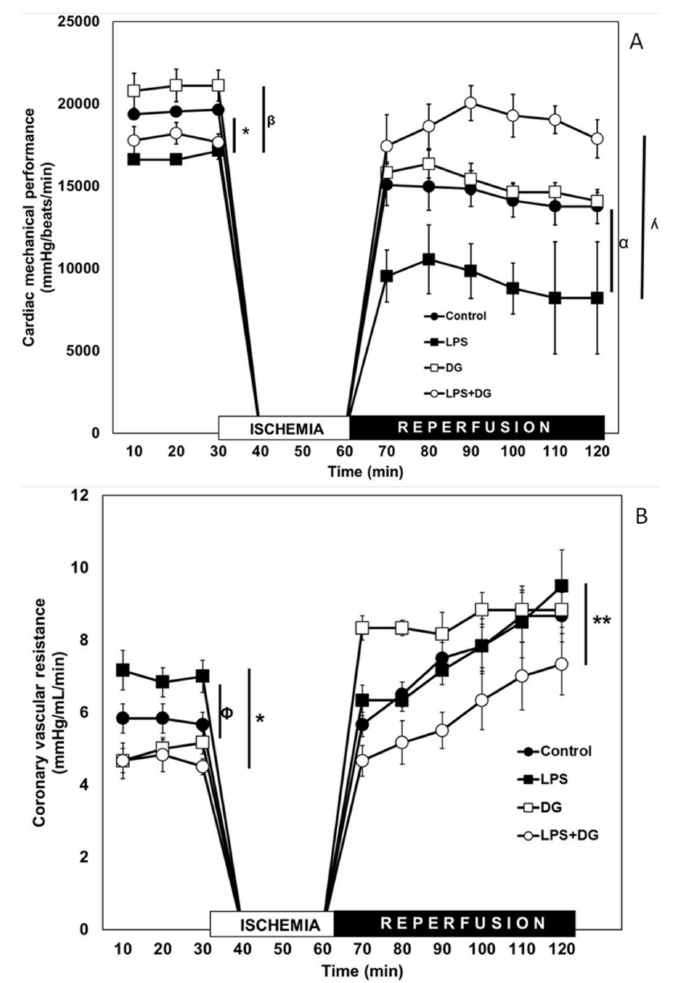
Figure 1. ( A ) Cardiac mechanical performance and ( B ) coronary vascular resistance of hearts with ischemia and reperfusion from the C (black circles), LPS (black squares), DG (white squares), and LPS + DG (white circles) groups. The hearts were isolated and dissected from rats with different treatments and perfused for 30 min. After that time, an ischemia-reperfusion period (I/R) was applied, I = 30 min and R = 60 min. Each heart was its own control to compare the pre-ischemic period vs. I/R, n = 6, p ≤ 0.05. CMP = Pre-ischemic period significance. * Control vs. LPS p = 0.001, β LPS vs. DG p = 0.001. Reperfusion significance: α DG vs. LPS + DG p = 0.02, ň LPS vs. LPS + DG p = 0.03. CVR = Pre-ischemic period: Ø LPS vs. DG p = 0.003. * LPS vs. LPS + DG p = 0.002. Reperfusion significance: ** DG vs. LPS + DG p ≤